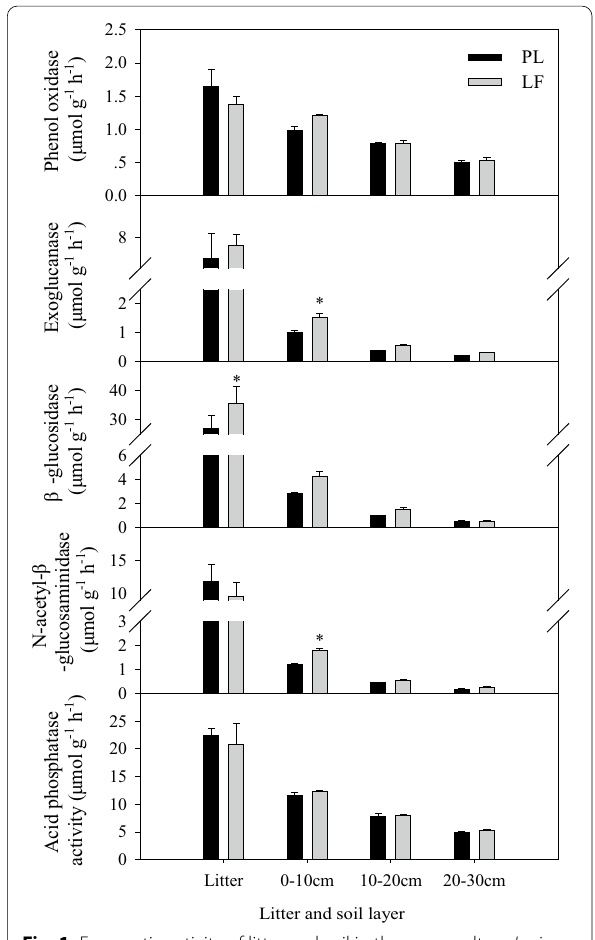
Fig. 1 Enzymatic activity of litter and soil in the monoculture Larix gmelinii plantation (PL) and mixed L. gmelinii – Fraxinus mandshurica plantation (LF). Values are presented as means significant differences between the monoculture and mixed plantations at the P < 0.05 level